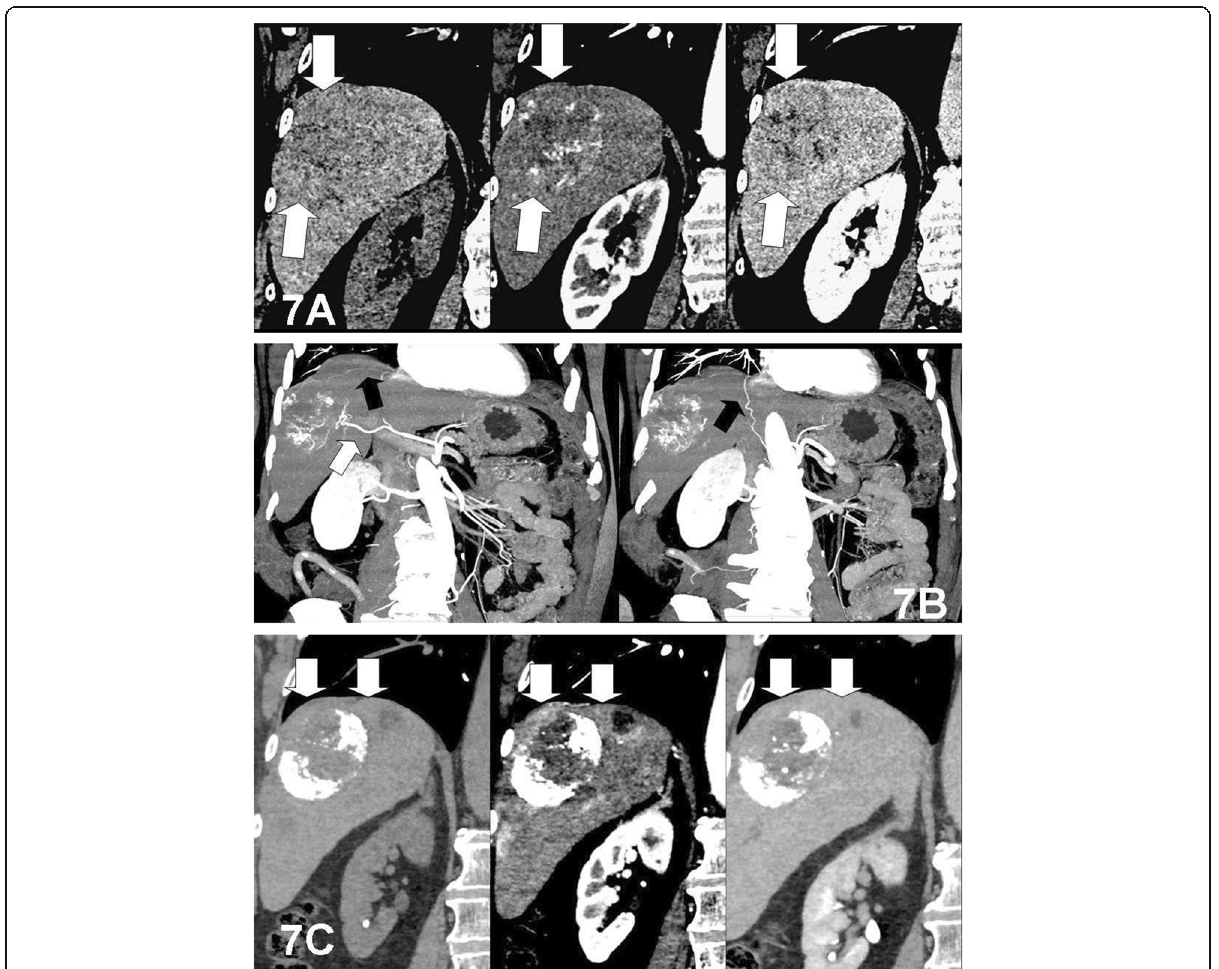
Fig. 7 Initial multi-phase CT liver with a coronal non-contrast, arterial and delayed phases showing a large hepatic dome HCC (white arrows) with heterogeneous arterial enhancement and delayed wash-out. b Coronal MIP showing arterial supply of the lesion by both the right hepatic artery (white arrow) and by extra-hepatic right inferior phrenic artery (black arrow). c Follow-up CT, 6 months after TACE without RIPA embolisation, showing residual activity at the cephalic portion of the lesion with progression of the lesion to the nearby liver parenchyma (white arrows) with lipiodol retention and inactive caudal